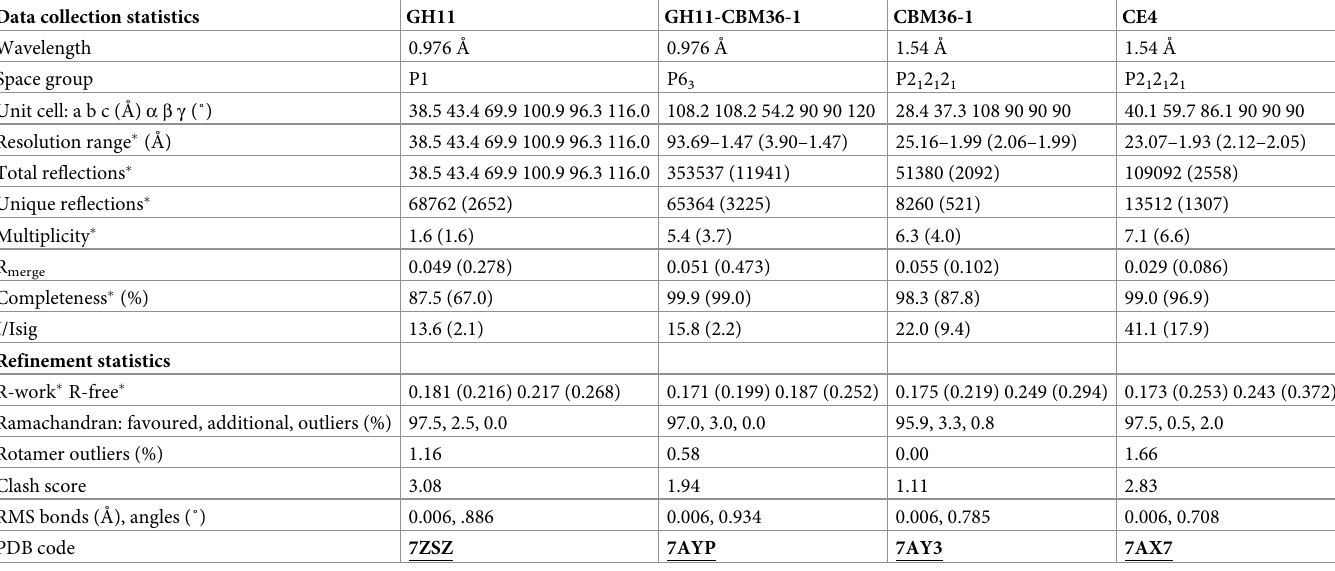
Table 1. Data collection and refinement